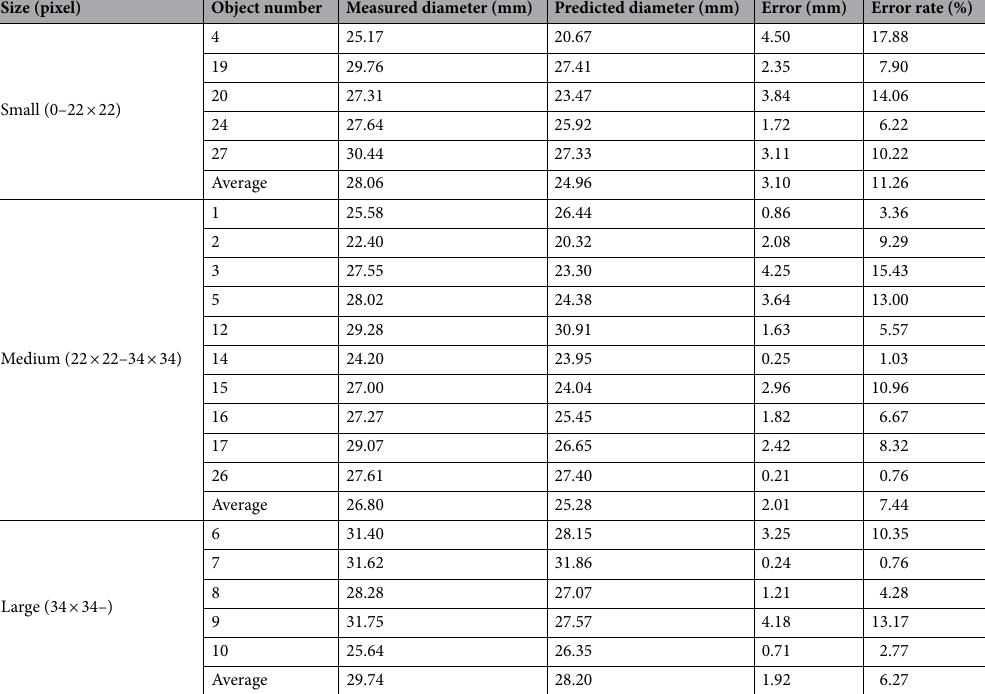
Table 4. Results of applying growth evaluation algorithm to an outdoor image.